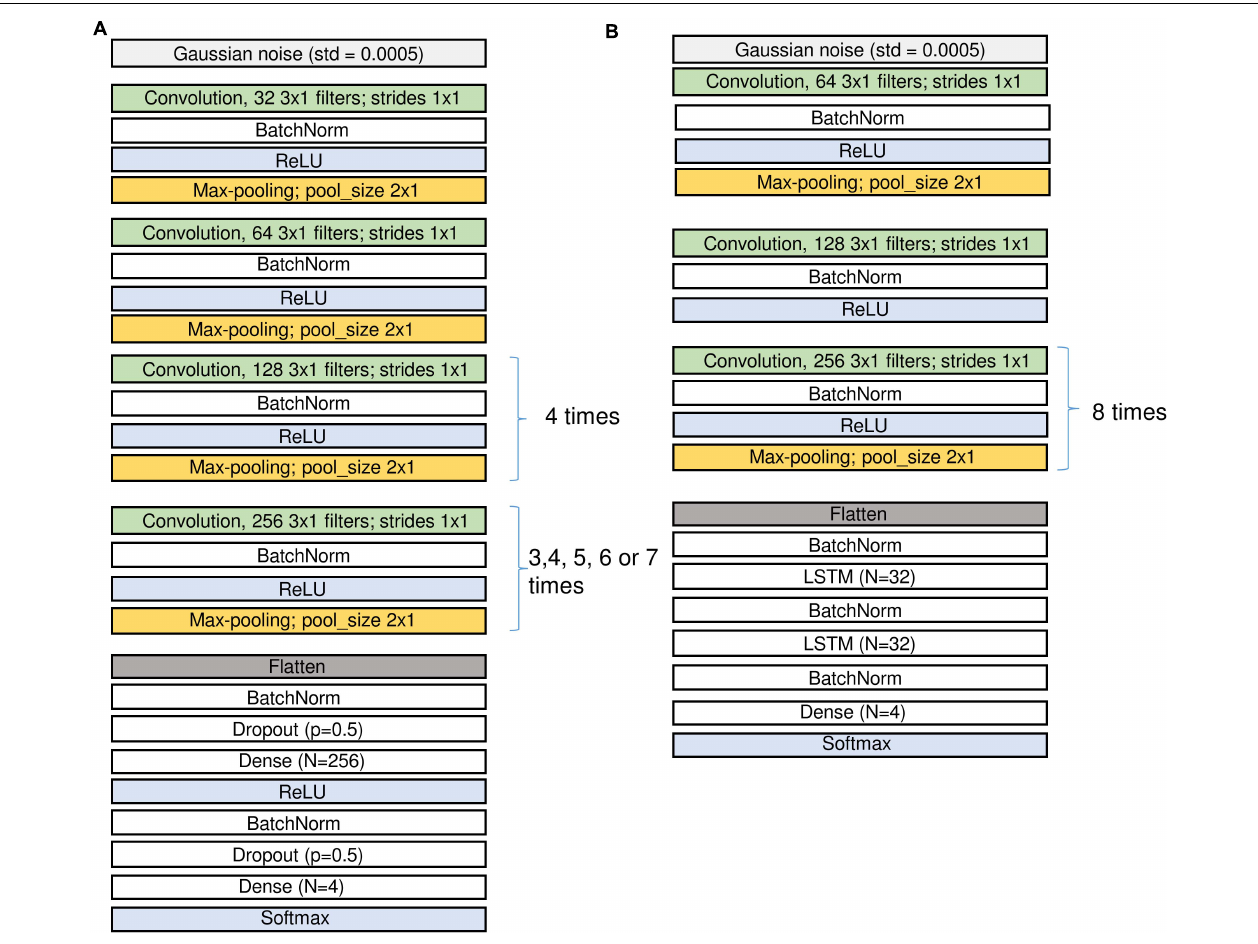
FIGURE 2 | Structure of the CNN (A) and the CNN-LSTM (B) networks. Input is on top, output at the bottom. Since we applied several configurations of the CNN networks the repetitions of the last convolutional and pooling blocks were different. The number of channels in the input may differ for the networks using either an EEG and two EOG channels or a single EEG channel only. See sections “Architecture of the Networks” and “Materials and Methods” and Table 2 for the description of the different